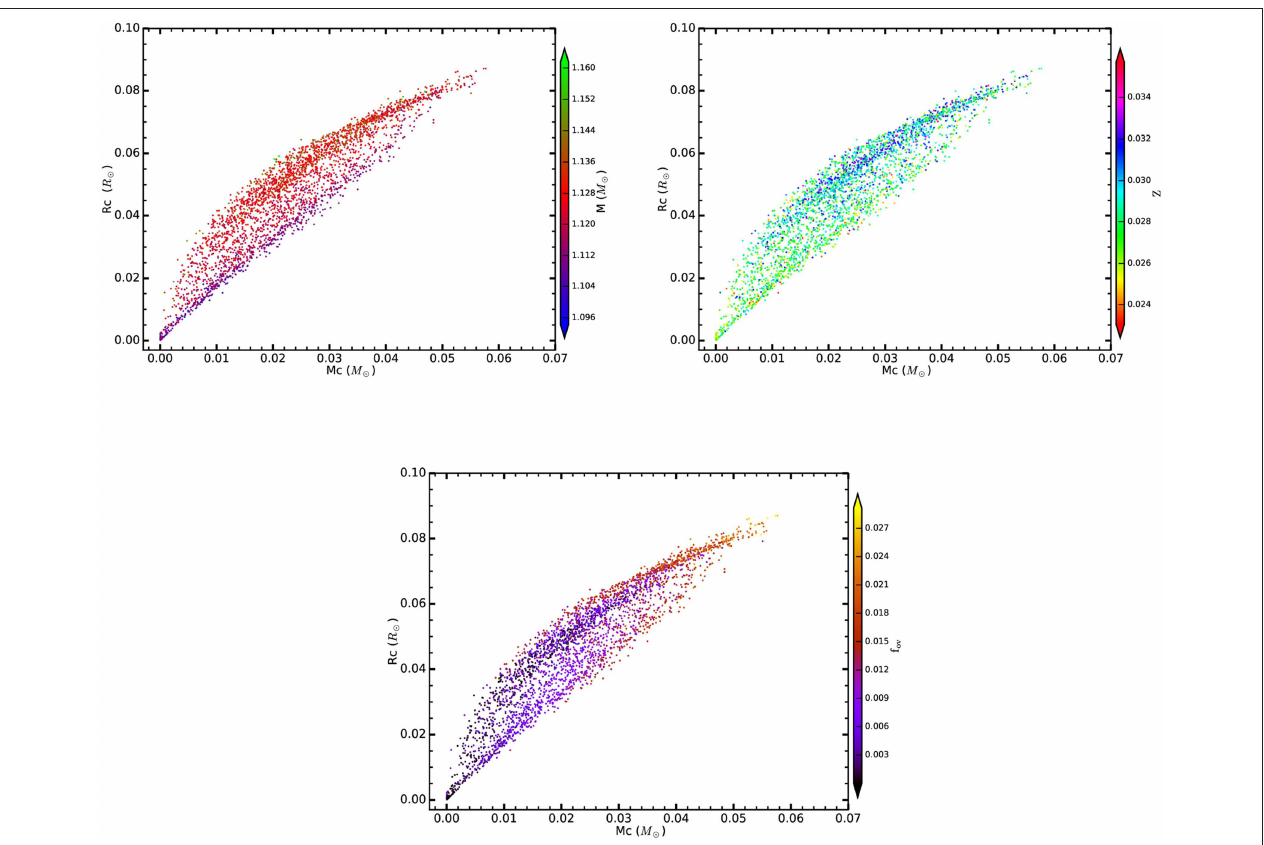
FIGURE 3 | Scatter plots showing core radius ( R c ) vs core mass ( M c ) for best-fit models with convective cores obtained using grid B (Run I). Top left is color-coded according to the model mass ( M ), top right is color-coded according to the initial metal mass fraction ( Z ), and bottom panel is color-coded according to the overshoot parameter ( f ov